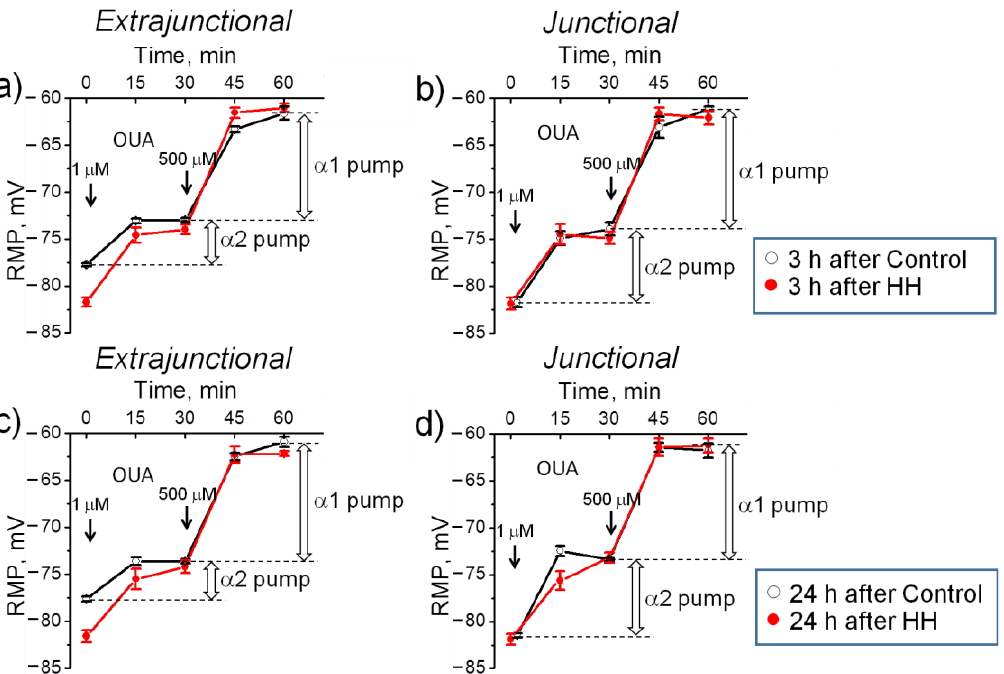
Figure 2. Changes in the resting membrane potential (RMP) of diaphragm muscles isolated from rats subjected to hypobaric hypoxia (HH) at a pressure equivalent to an altitude of 3000 m for 3 h. The measurements were carried out on muscles isolated 3 ( a , b ) or 24 h ( c , d ) after control or HH treatment in the extrajunctional ( a , c ) and junctional ( b , d ) sarcolemmal regions. The electrogenic contribution of the α 2 and α 1 Na,K-ATPase was estimated by administration of 1 or 500 µ M ouabain (OUA, indicated by the corresponding arrows). Broad vertical arrows indicate electrogenic contributions generated by the α 1 and α 2 Na,K-ATPase isozymes in control muscles. Each data point corresponds to the averaged RMP measured in 5 muscles.